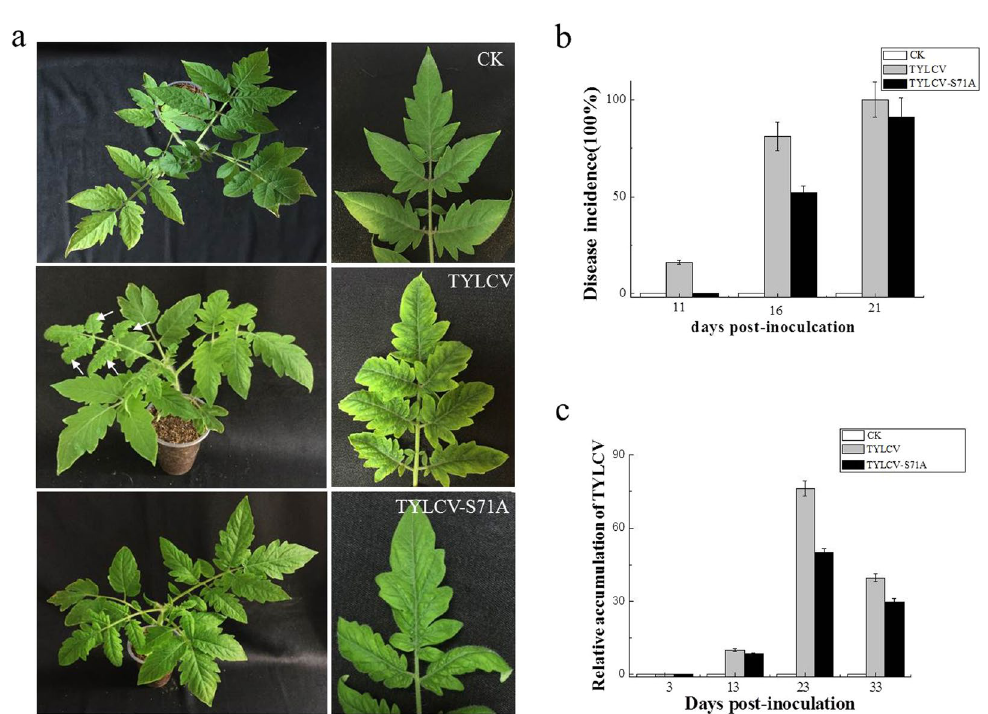
Figure 6. Effects of site mutation S71A on virus infection and relative viral DNA accumulation levels in agroinoculated solanum lycopersicum plants. ( a ) Symptoms of plants agroinoculated with TYLCV or TYLCV- S71A at 14 dpi. CK indicates the mock-inoculated plant. ( b ) Infection course of TYLCV or TYLCV-S71A. Values represent percentages of systemically infected plants at different dpi and are given as means ± SD of triplicate experiments. In each experiment, 12 plants were inoculated. ( c ) Accumulation of virus in TYLCV and TYLCV-S71A inoculated